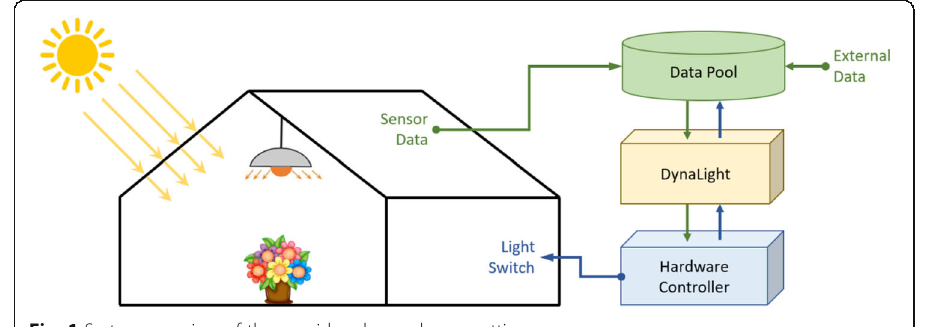
Fig. 1 System overview of the considered greenhouse